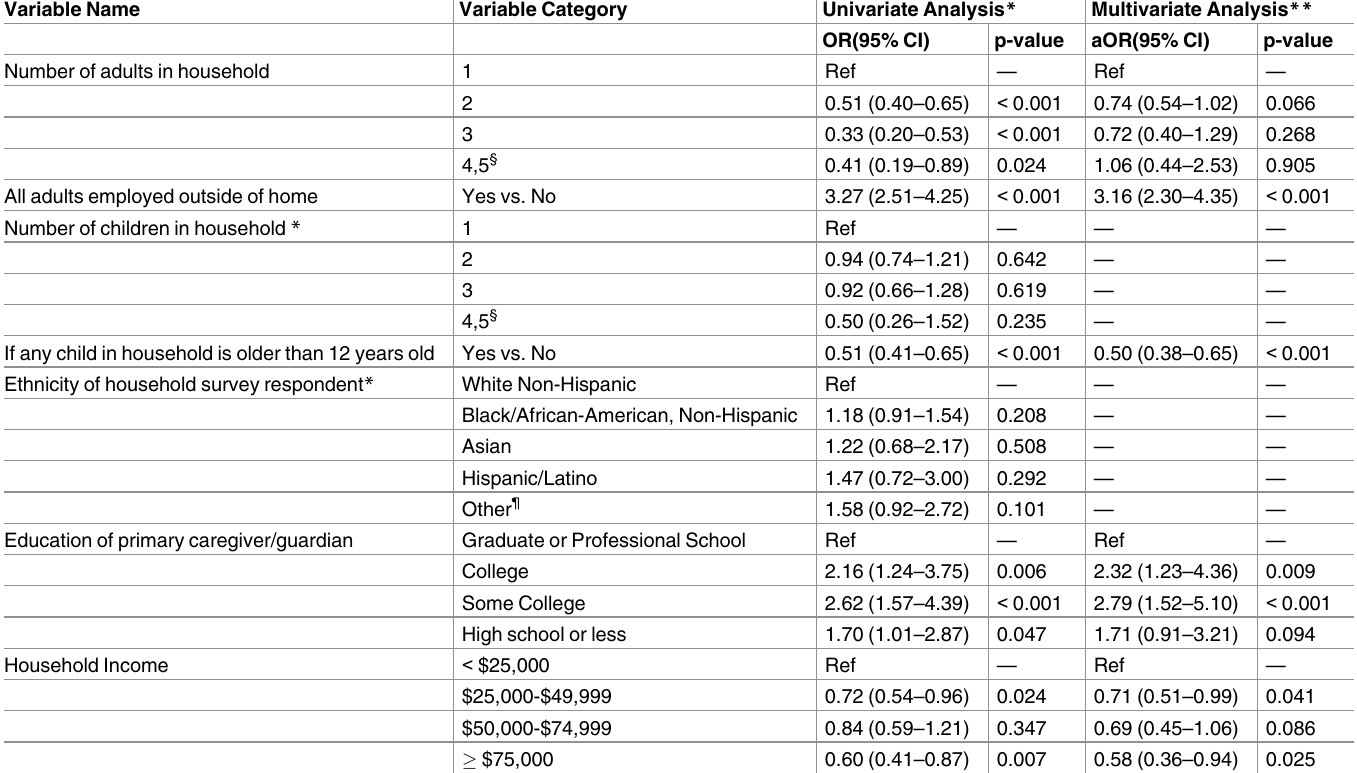
Table 4. Factors associated with difficulty arranging childcare during school closure. HarrisonCounty SchoolDistrict, Mississippi, August